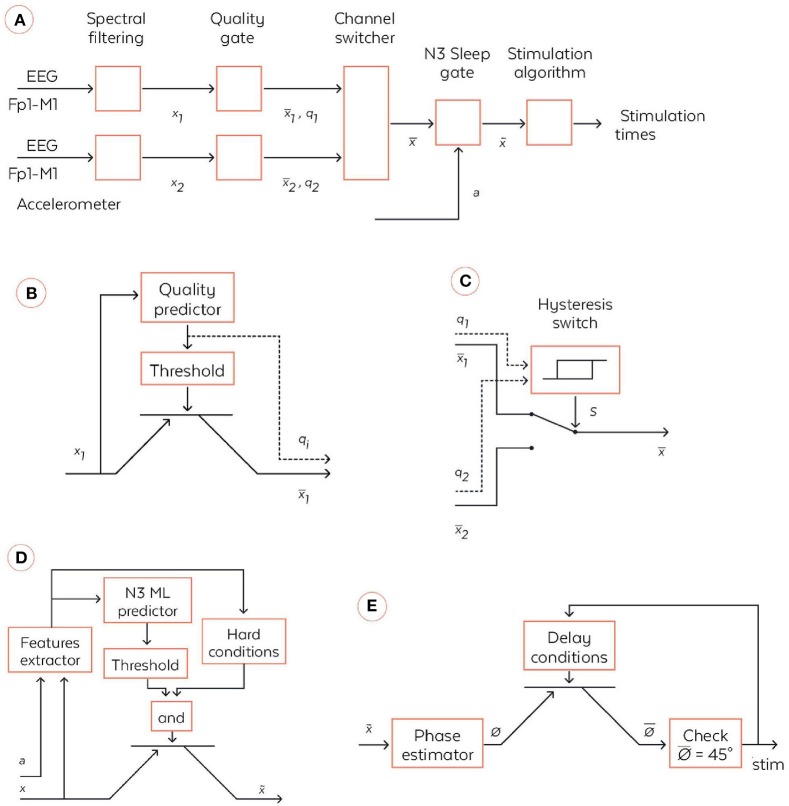
Coarse-grained algorithmic pipeline used by the WDD for stimulating N3 sleep. (A) General pipeline. (B) Quality gate representation, High-level block diagram of the quality gate. The filtered signal xi (with i∈{1,2}) are sent to the quality predictor which computes an index of the signal quality qi∈[0,1] (0 means bad signal and 1 means perfect signal). This is a quantification of the extent to which the signal is perturbed by external artifacts, e.g., due to dry electrode bad contact. This quality index is the compared to a threshold to open or not the quality gate, which is illustratively represented via a transistor symbol. The output signal x¯I is equal to xi if qi > {threshold} and is Not a Number (NaN) else. (C) High-level block diagram of the channel switcher. The two quality indices q1 and q2 enter an hysteris switch which selects which inputs, x¯1 or x¯2, are broadcasted to the next block. The hysteris switch is parameterized by a threshold θ and outputs a binary variable at time t computed as s(t) = 1 if q1-q2 > θ or [–θ < q1-q2 < θ and s(t-1) = 1]. Symmetrically, s(t) = 0 if q1-q2 < –θ or [–θ < q1-q2 < θ and s(t-1) = 0]. If s(t) = 1 then x¯ = x¯1 and, if s(t) = 0 then x¯=
x¯2. (D) N3 Sleep gate representation. High-level block diagram of the N3 sleep gate. Both inputs, the accelerometer a∈ℝ3and the virtual channel x¯∈ℝ, are used in a series of operations to identify whether, the input corresponds to N3 sleep, in which case the virtual channel is broadcasted to the next block. More precisely, a and x¯ enters a series of signal processing functions in the feature extractor. Not only are basic statistics of the two signals computed, but also some classical patterns of N3 sleep such as spindles and SO are identified. The extracted features are sent to a machine learning predictor which outputs an estimation of the probability to be in N3. In parallel, the features are used together with time information to check if several hard conditions are met: once the first N3 is detected, wait 15 min before starting to; do not stimulate if a large movement happened less than 3 min ago; stop to stimulate 4 h after the first detection of N3. If both the hard conditions are met and the N3 machine learning predictor outputs a probability to be in N3 larger than a threshold then x~=x¯, else x~=NaN. (E) High-level block diagram of stimulation algorithm. First, the virtual channel is sent to a block, which estimates the phase of the signal in the delta band. We used a new phase detection algorithm here, which is described in the text body. Next the algorithm checks whether the phase is equal to 45°, the target that is set for stimulation, and emits a stimulation. However, there is a delay condition from the previous stimulation to ensure we do not stimulate at each SO. The two rules used here are: (i) do not stimulate more than two SO in a row, (ii) wait at least 9 s before the previous pair of stimulations. If those delays conditions are met, then the stimulation order is given to the hardware, which emits 50 ms stimulation through the bone conduction.